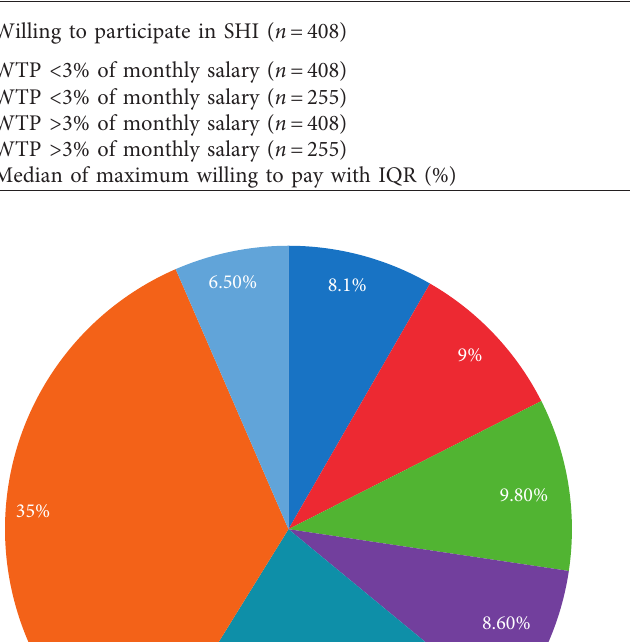
Table 2: Health professionals’ acceptance for social health insurance in government hospitals, Mekelle City, North Ethiopia, 2017. Variables